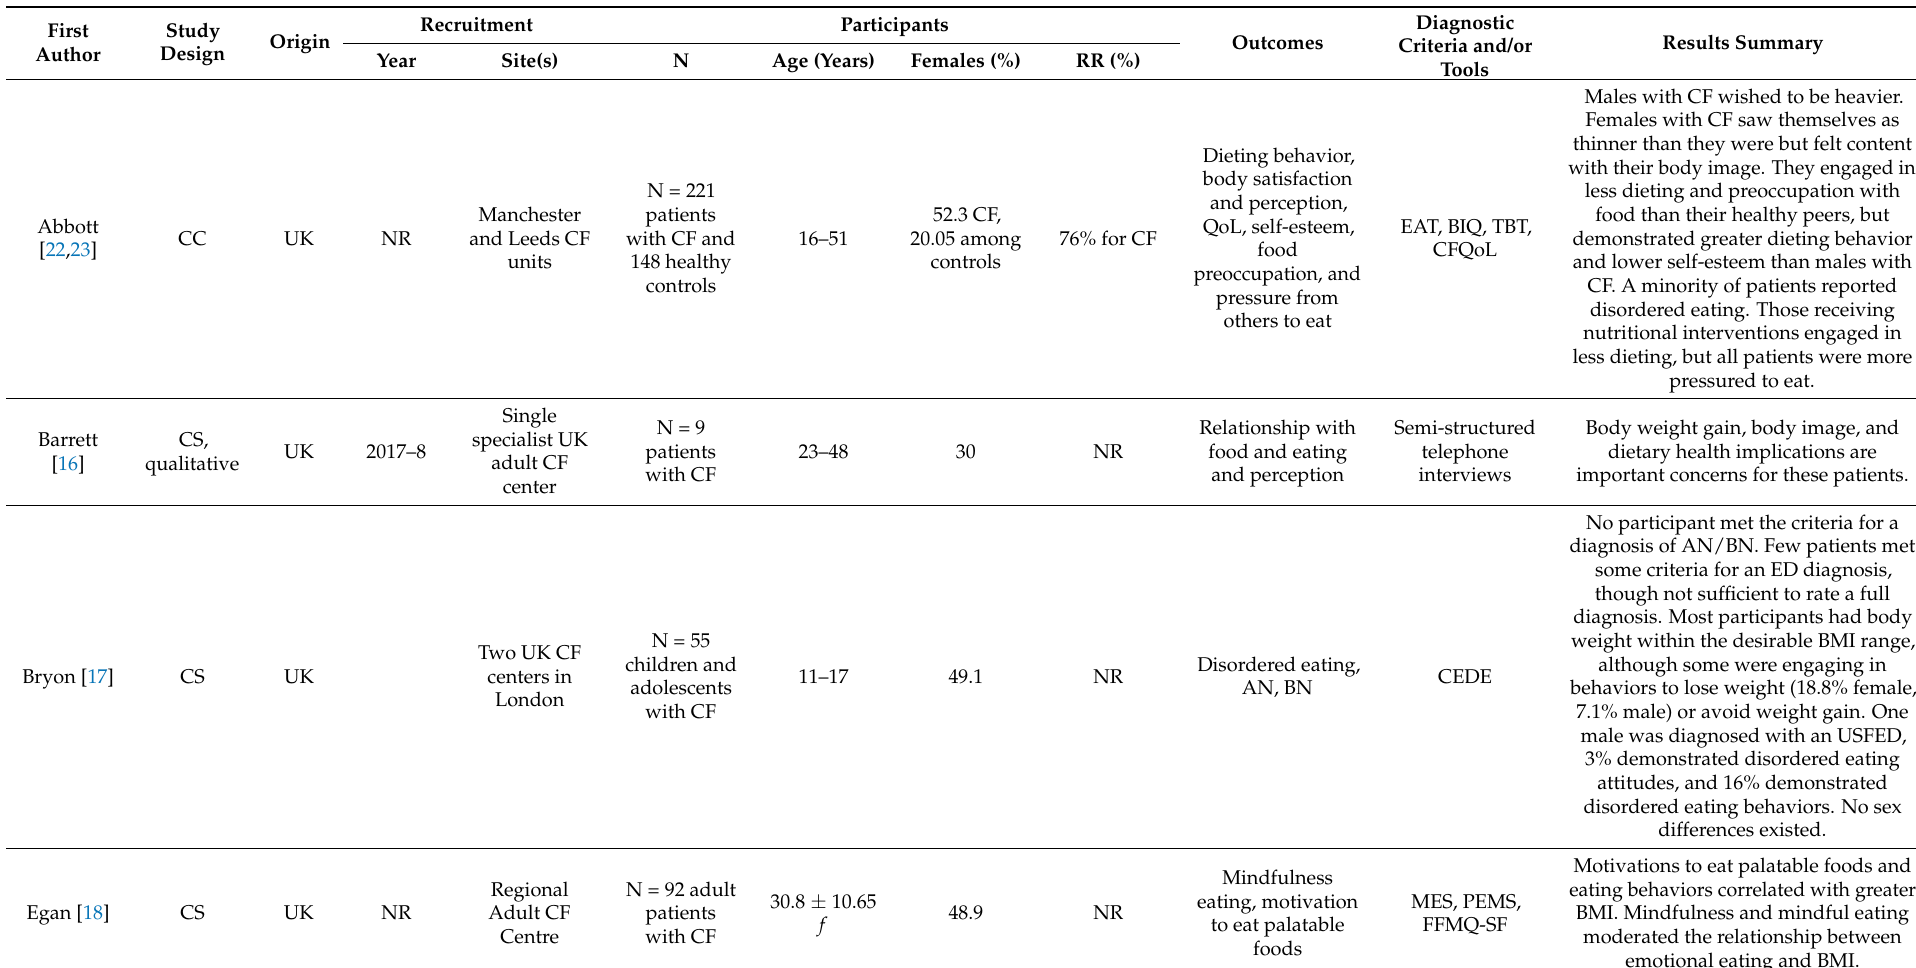
Table 1. Primary studies assessing the prevalence of disordered eating, EDs, or other specified feeding and EDs among patients with